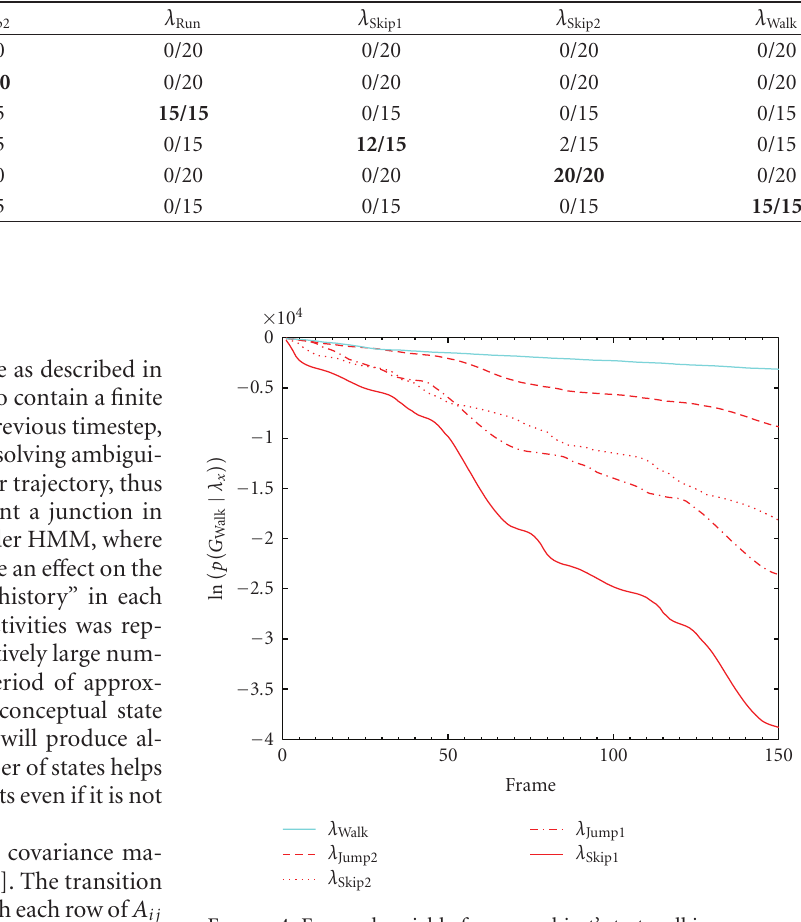
Figure 4: Forward variable for one subject’s test walking